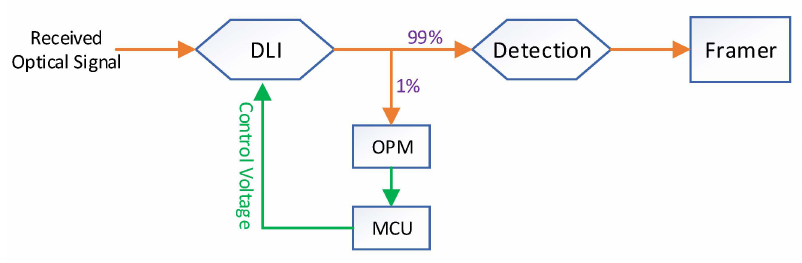
Figure 3. Dynamic DLI control voltage adjusting.